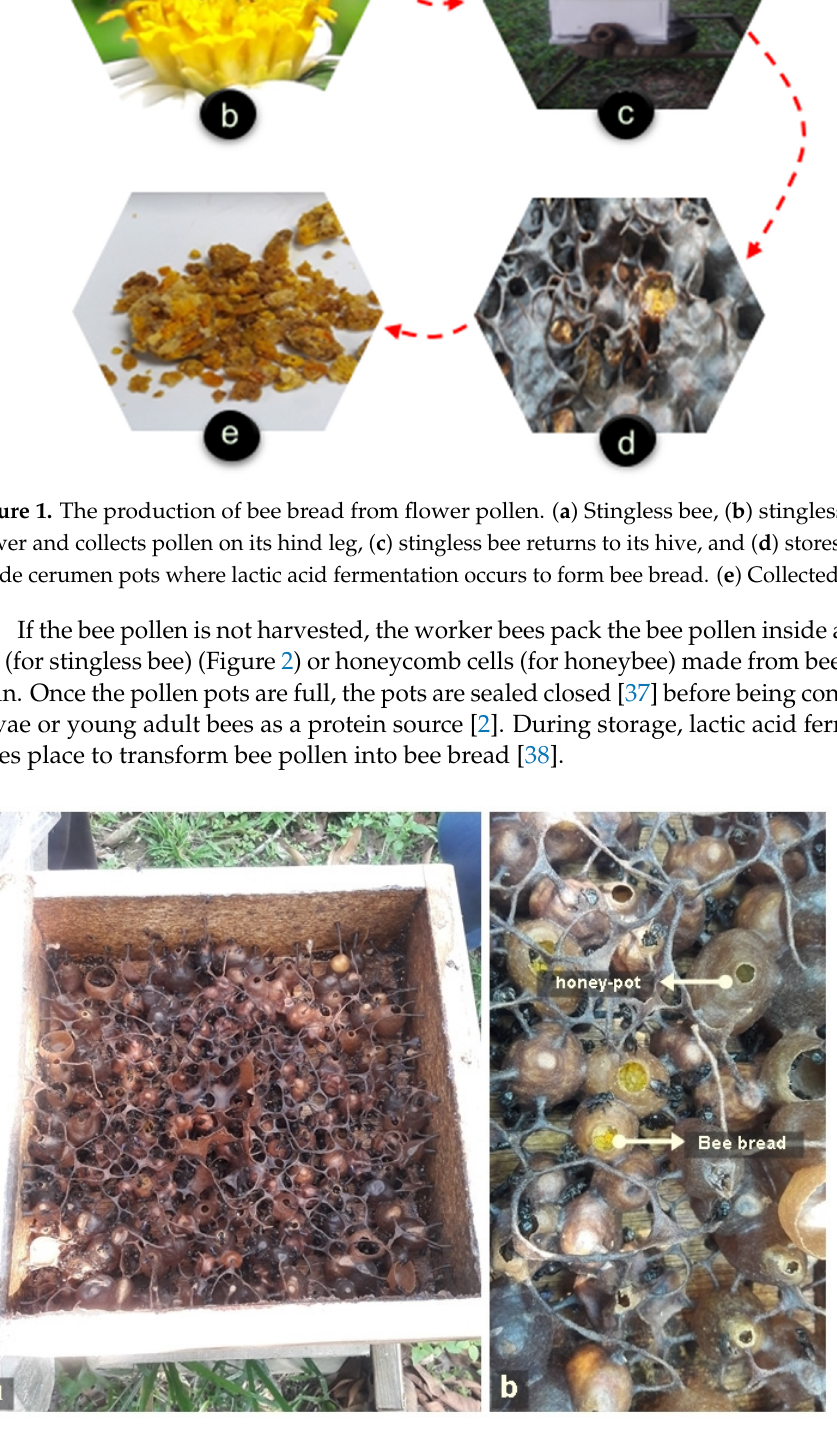
Figure 2. ( a ) Stingless bee colony and ( b ) honey and bee bread in separate cerumen pots.